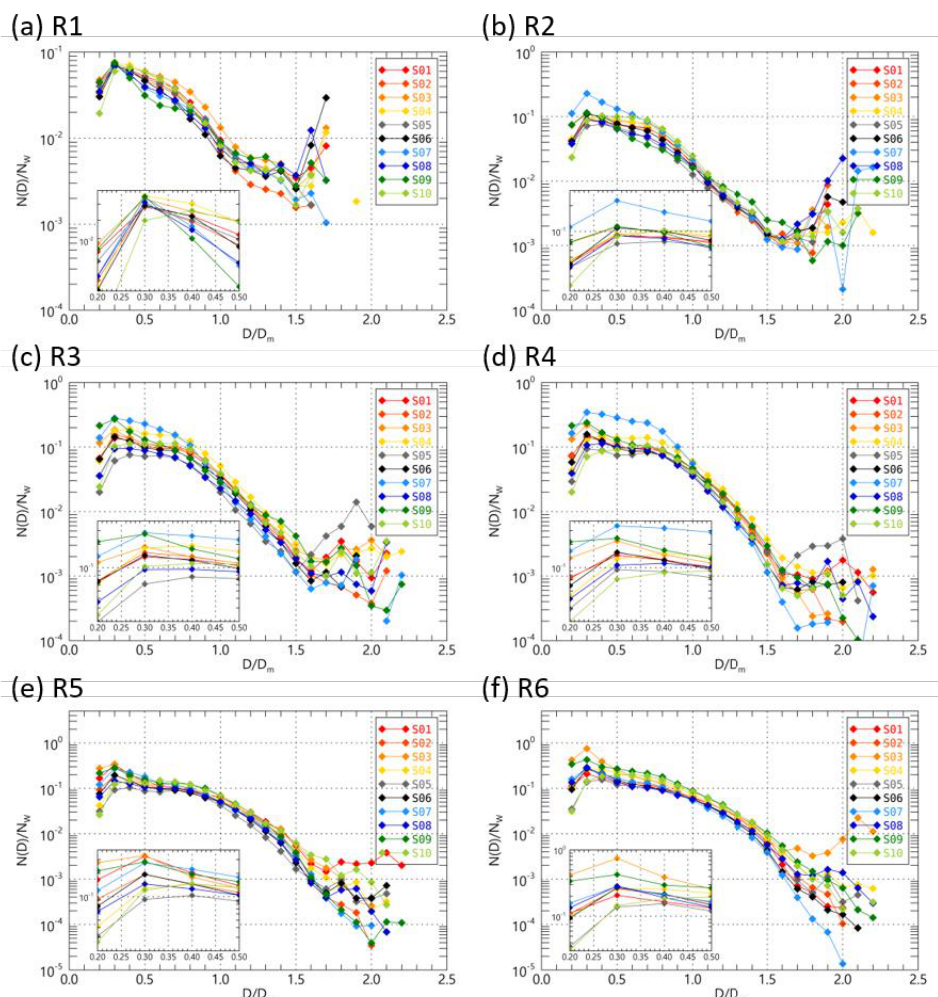
Figure 3. The normalized N(D) versus normalized diameter of raindrops for rain rate categories at the 10 Parsivel sites during the entire analysis period. The inner subfigures show the average normalized N(D) versus normalized diameter from 0.0 mm to 0.5 mm.